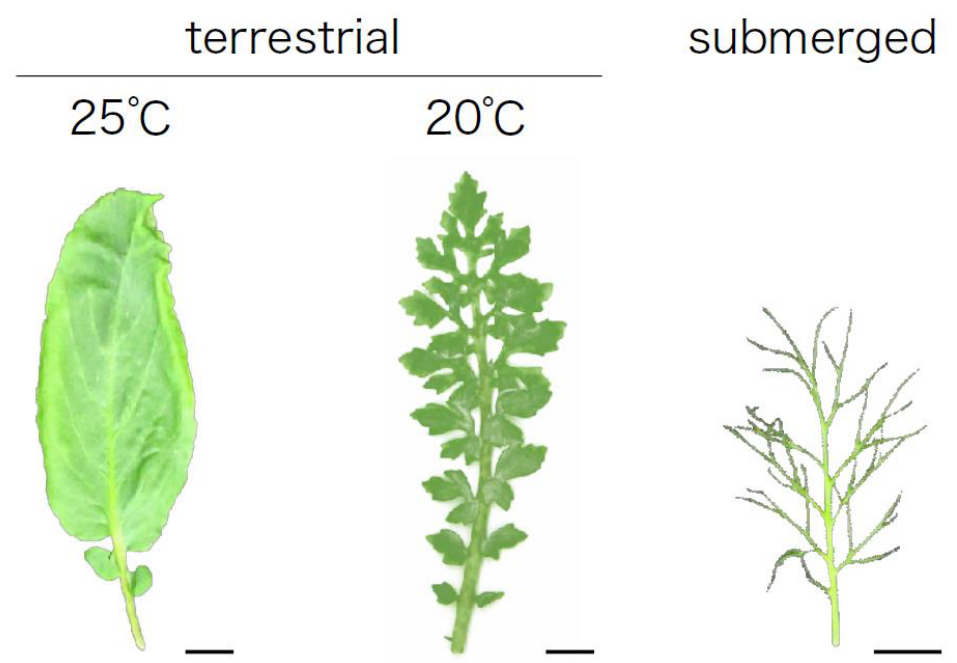
Figure 1. Heterophylly of amphibious plant, North American lake cress, Rorippa aquatica (Brassicaceae). North American lake cress shows distinct heterophylly between submerged and terrestrial conditions. Leaf shape alternation is also induced by changes in ambient temperature. Bars, 1cm.